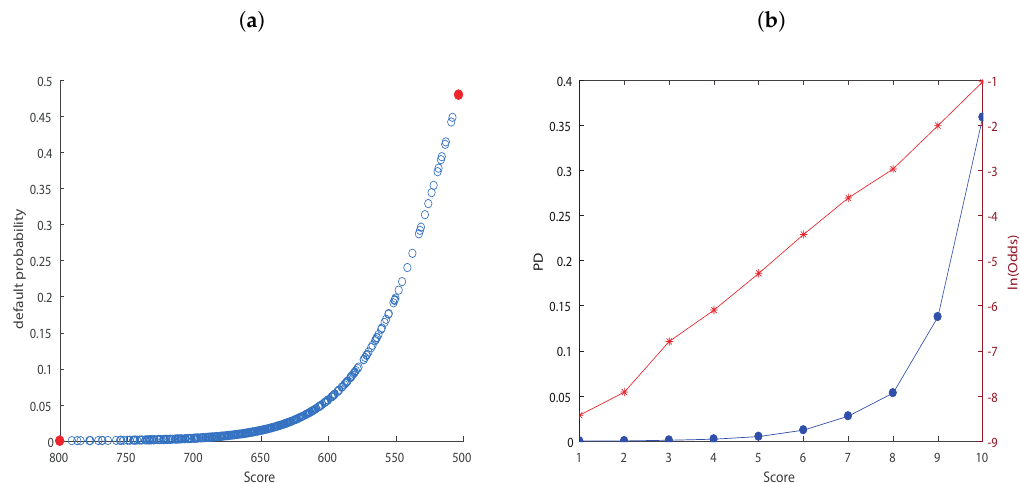
Figure 1. Panel ( a ) illustrates the relationship between score and PD. For each company we compute a score based on the logistic regression output that is an indication of individual PD. Panel ( b ) shows the master scale. This is an indicator of the counterparty’s riskiness level. For its creation, we follow the approach presented by Siddiqi (2017). The default probability is linearized through the calculation of the natural logarithm, then the vector of the logarithms of the PD is divided into 10 equal-sized classes and the logarithms of the cut-offs of each class is converted to identify the cut-offs to be associated with each scoring class with an exponential